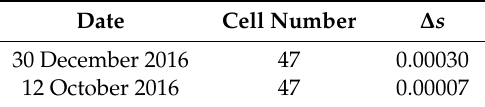
Figure 8. ( a ) The curve of voltage of Vehicle 1; ( b ) The curves of current, SOC and mileage of Vehicle 1. Table 3. ∆ s of Vehicle 1 at different